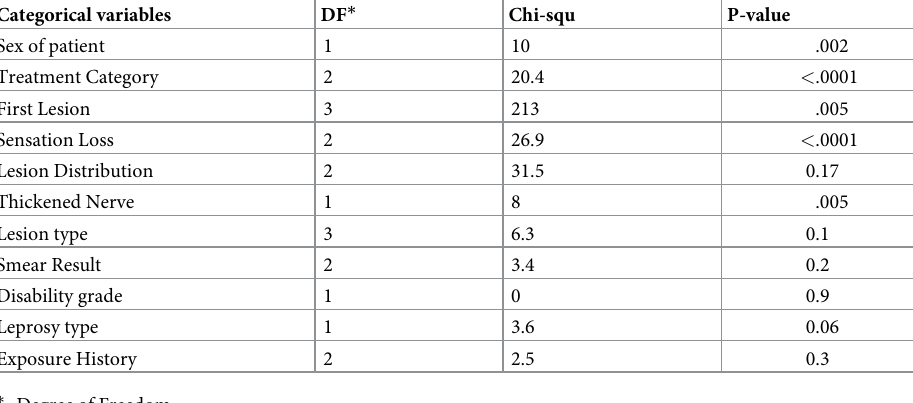
Table 4. Results of the log-rank test for each categorical variable, LPAC, 2015–2019.